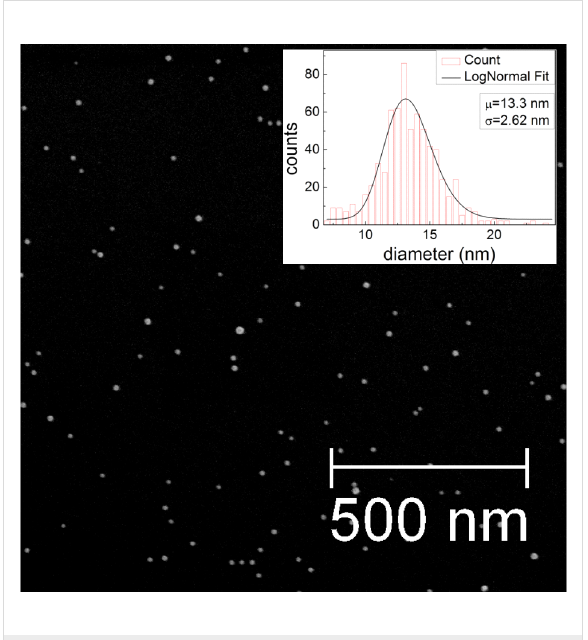
Figure 1: Scanning electron micrograph of Fe nanoparticles deposited on Si. The average particle size observed is 13.3 nm.